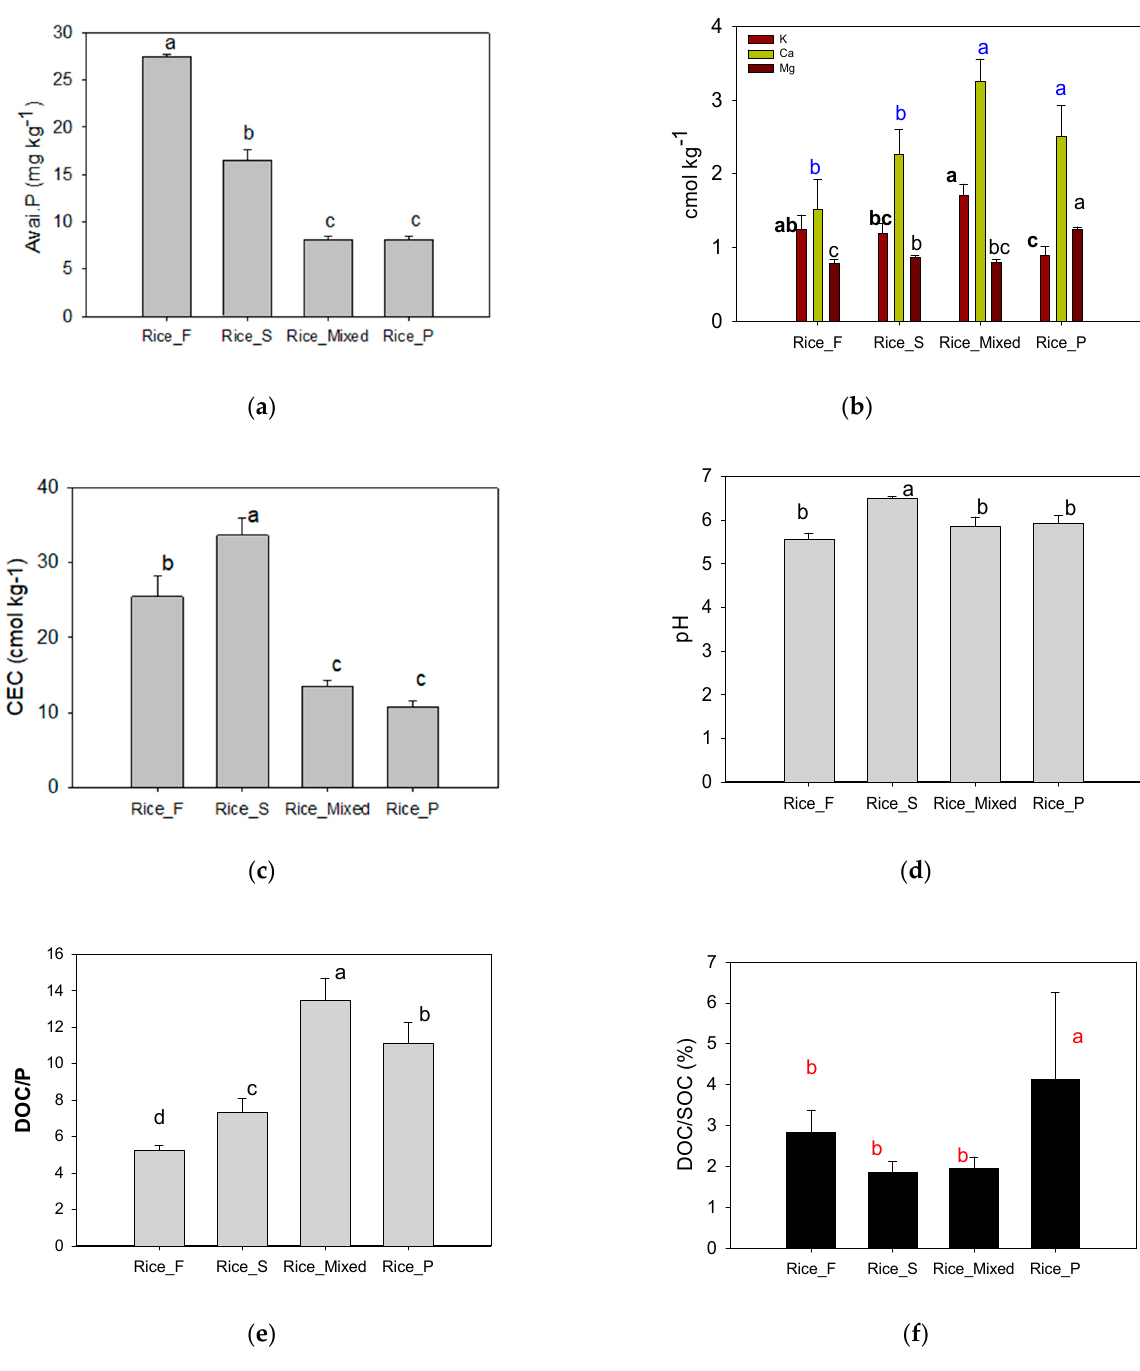
Figure 4. Various chemical properties of the RRCSs: Avail P ( a ); exchangeable K + , Ca 2+ , and Mg 2+ ( b ); CEC ( c ); pH ( d ); DOC/P ratio ( e ); and DOC/SOC ( f ). Note: The bars with the standard error of the mean and labeled with different lowercase letters indicate a difference between rice rotation patterns ( p < 0.05). In the rice cultivation system, different crops are used each year. Rice_ F = rice followed by a fallow period, i.e., no plantation; Rice_S = rice followed by shallots; Rice_Mixed = rice followed by tobacco, maize, and vegetables; and Rice_P = rice followed by